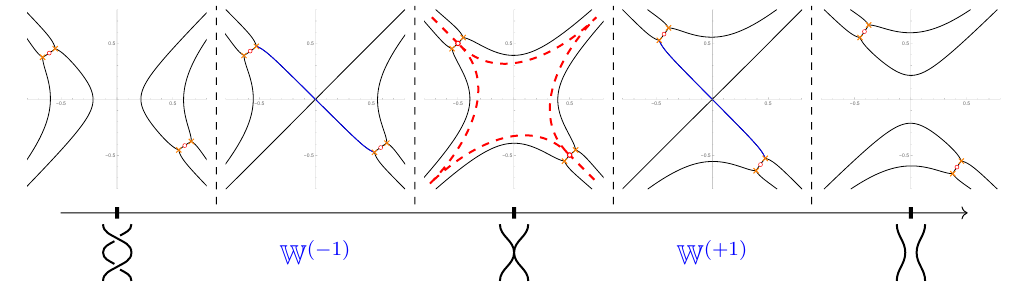
Figure 9 . Family of link diagrams and corresponding spectral